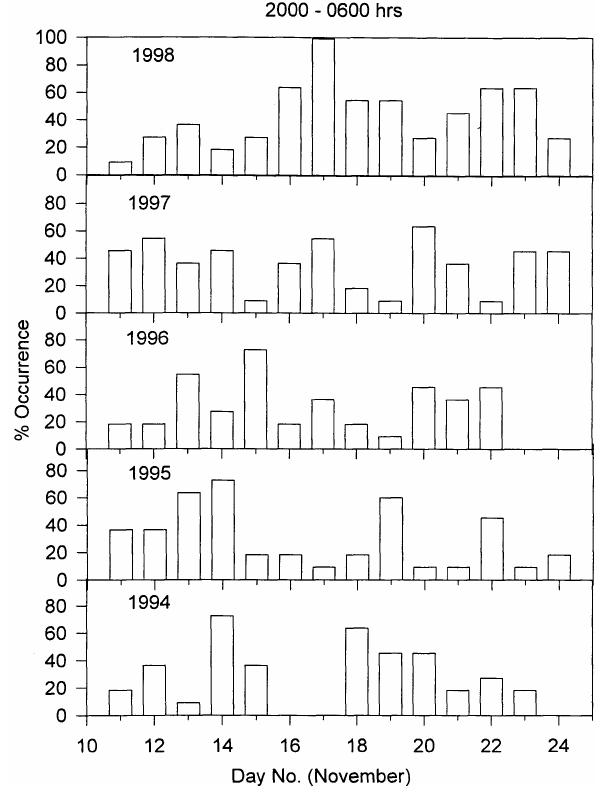
Fig. 2. Mean nighttime (20–06) percentage occurrence of sporadic- E over Ahmedabad for the days 11–24, November of years 1994– 1998 based on hourly